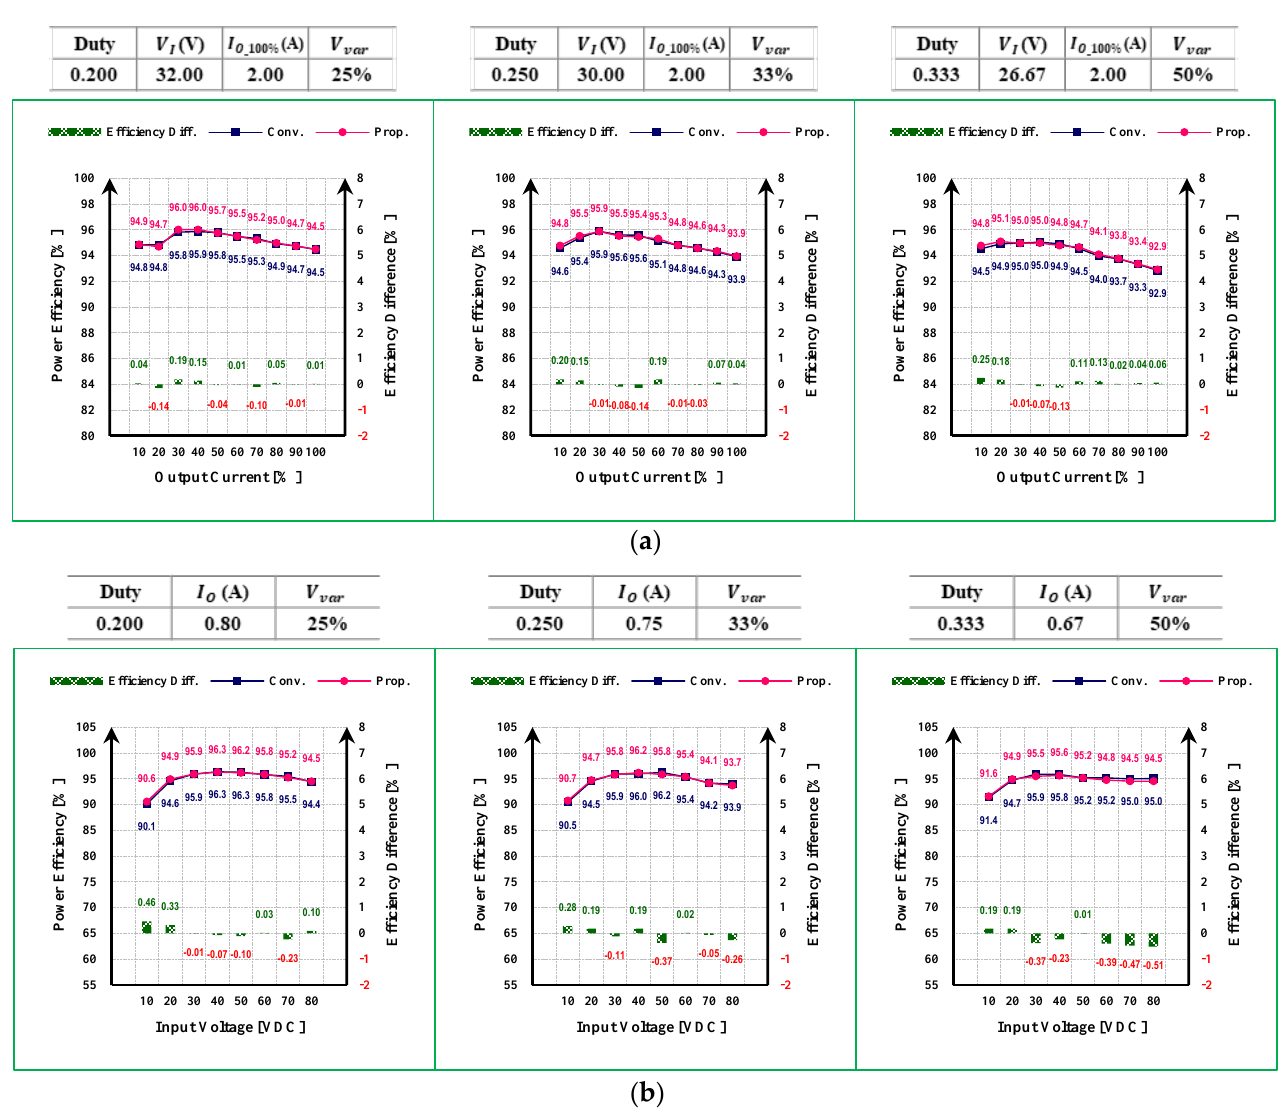
Figure 10. Power efficiency comparison of the boost topology: ( a ) CV mode; ( b ) CC mode.